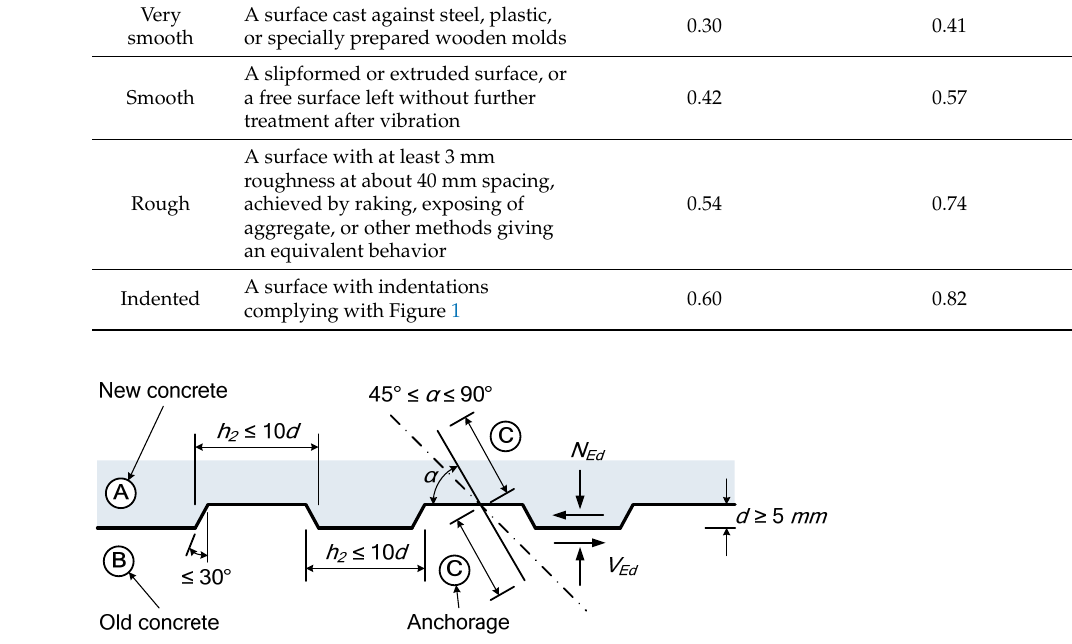
Table 1. Interfacial horizontal shear strength specified in EC 2 [8,26].